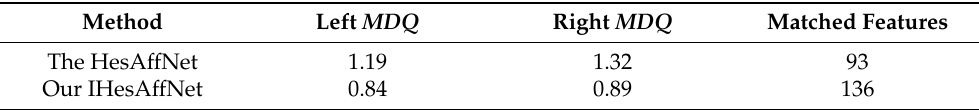
Figure 3. Comparison between the AffNet and IHesAffNet on the Graf1-6 stereo image dataset. ( a , c ) are the detecting results by the AffNet and IHesAffNet, respectively; ( b , d ) are the verifiable tests based on the detection of ( a , c ), respectively. The yellow and cyan ellipses respectively denote the detected and matched features. Note that the bottom row that corresponds to our approach is better. Table 2. Comparison of the AffNet and IHesAffNet in terms of feature distribution and repeatability on the Graf1-6 stereo image dataset.